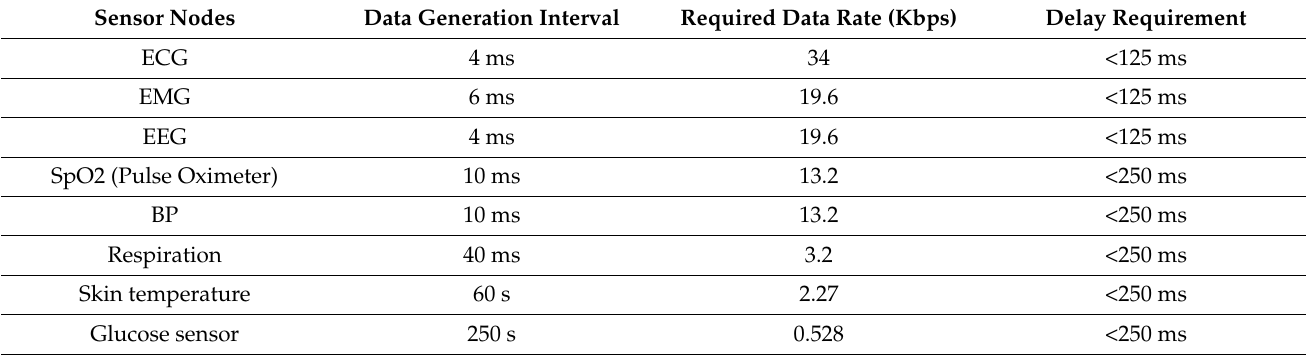
Figure 1. Wireless body area sensor network overview. Table 1. Requirements of sensors for patient monitoring systems